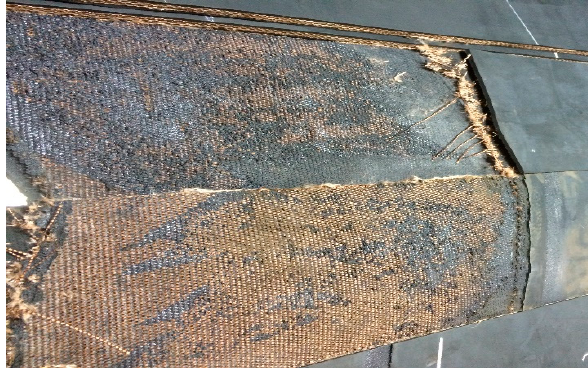
Figure 12. Roughened ply in the splice on belt type EP 1800/5.